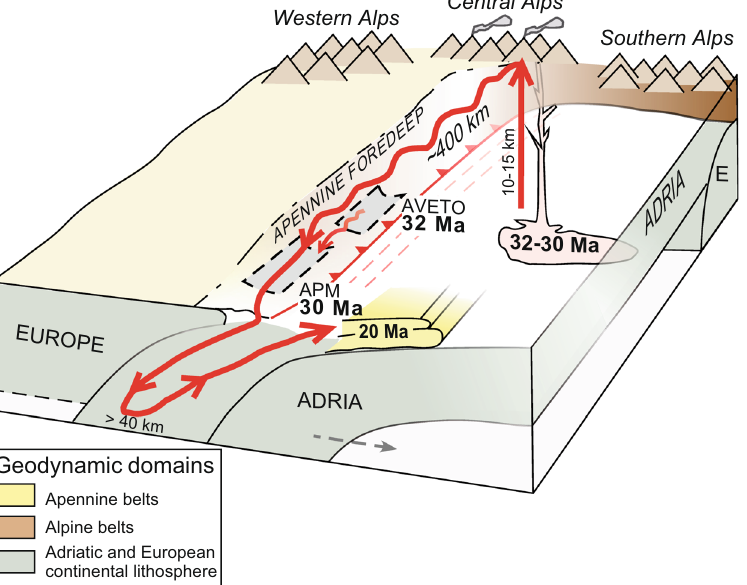
Figure 4. Zircon roller coaster model, not to scale. Time-transgressive (32 to 20 Ma) schematic zircon roller coaster model for the analysed samples: volcanic zircons originate in Periadriatic volcanic centres, are then translated 400 km along the Apennine foredee (similarly to what inferred for the Aveto unit 18 ) after which they are subducted to 40 km depth, as indicated by high-pressure metamoprphism of the APM unit 8 , before they are subsequently rapidly exhumed by 20